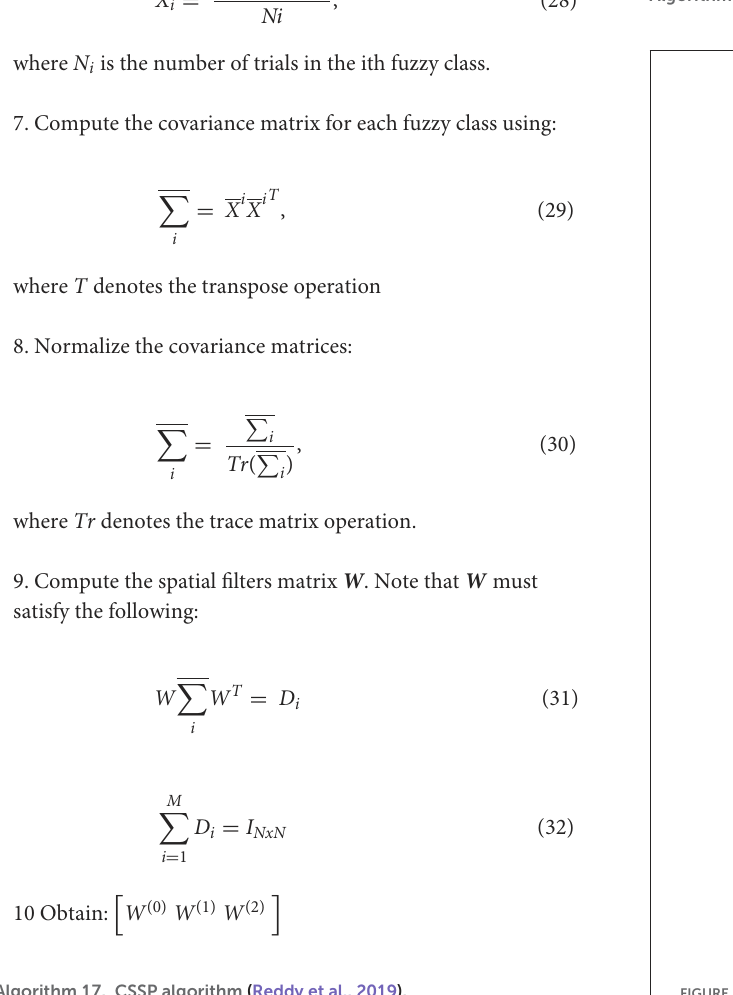
Algorithm 18. CSSSP algorithm (Dornhege et al., 2006).